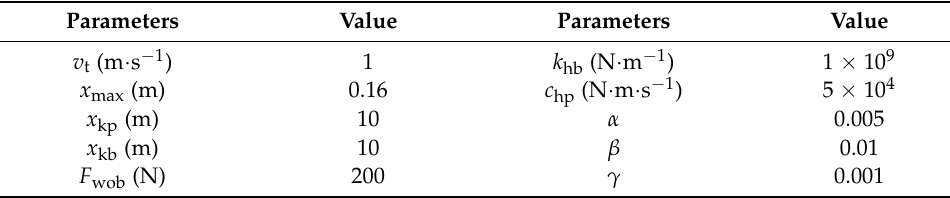
Table 3. Parameter values used for spring-mass-damping system